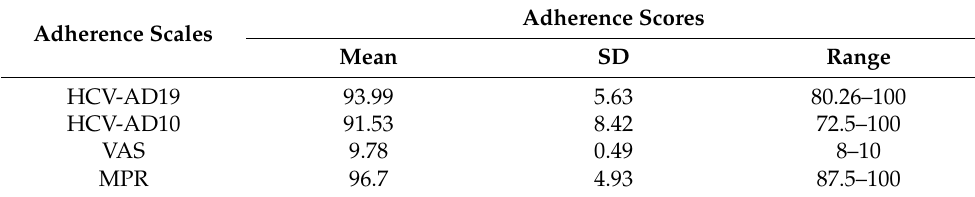
Table 6. Adherence scores calculated with the used